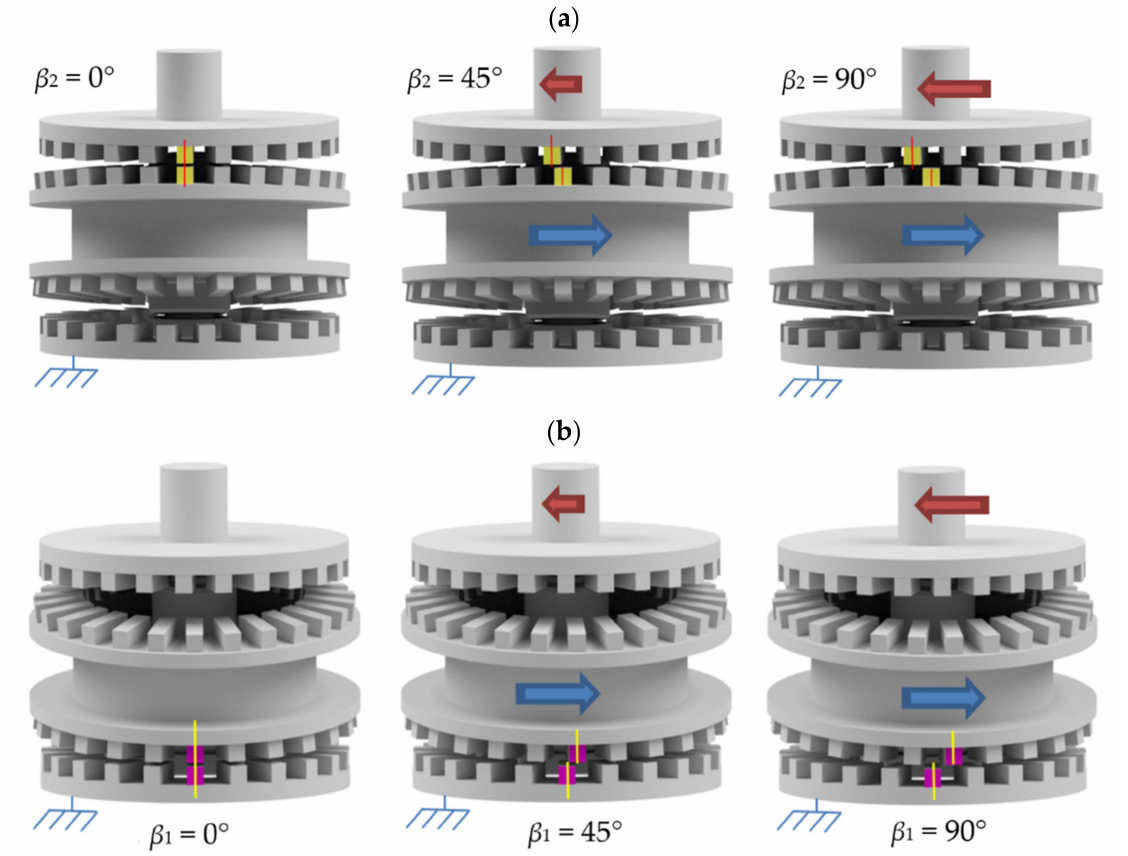
Figure 7. Illustration of the load angles: ( a ) β 2 and ( b ) β 1